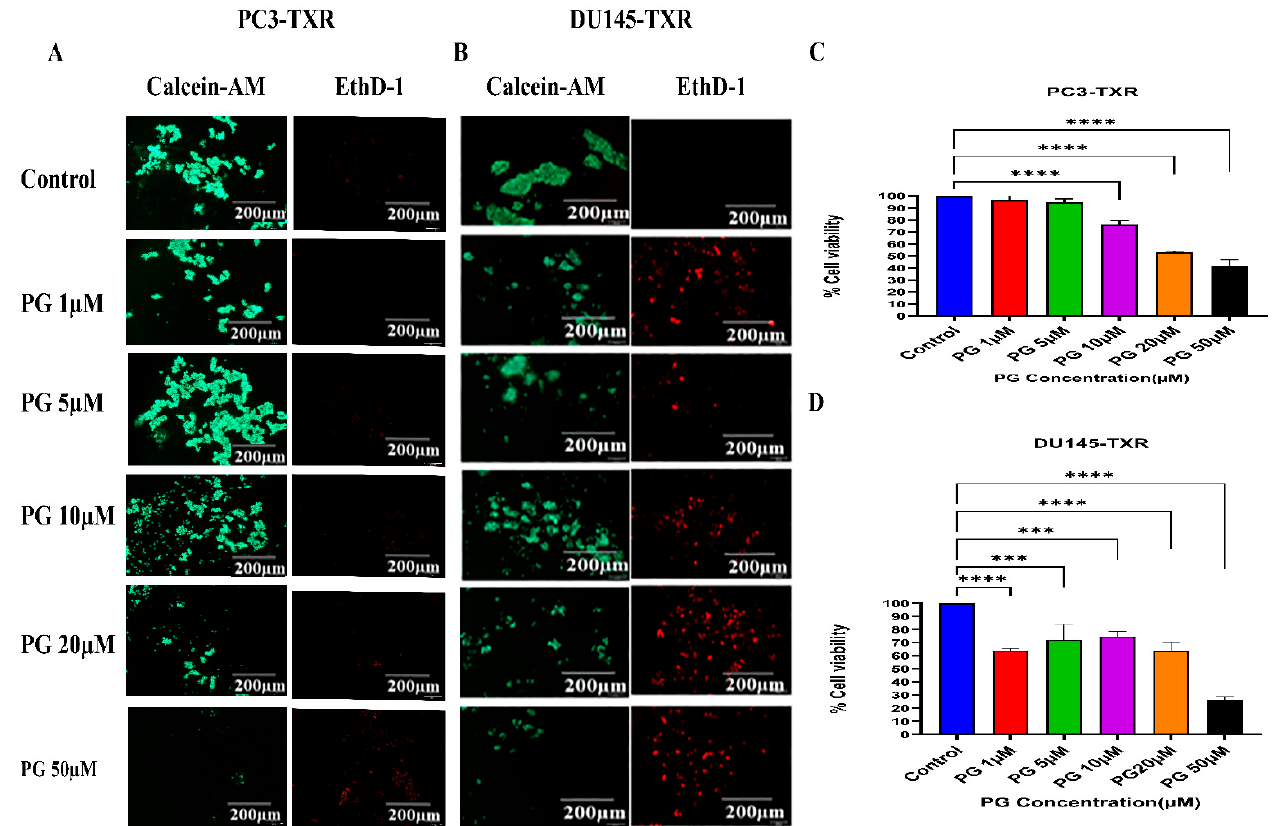
Figure 7. PG promotes anoikis in taxane-resistant PCa cell lines. ( A ) PC3-TXR and ( B) DU145-TXR cell lines were treated with varying concentrations of PG for 48 h and stained with calcein AM and EthD-1 to detect anoikis. We observed that with the increase in the concentration of PG, the number of viable cells stained with calcein-AM (green fluorescence) decreased, and the number of dead cells stained with EthD-1 (red fluorescence) increased. ( C ) and ( D ) % cell viability plotted against various concentrations of PG for PC3-TXR and DU145-TXR, respectively. Images were taken at 10 × magnification. Data are represented as mean ± SD ( n = 3), and a total of three experiments were performed independently in triplicate. *** p < 0.05, **** p <